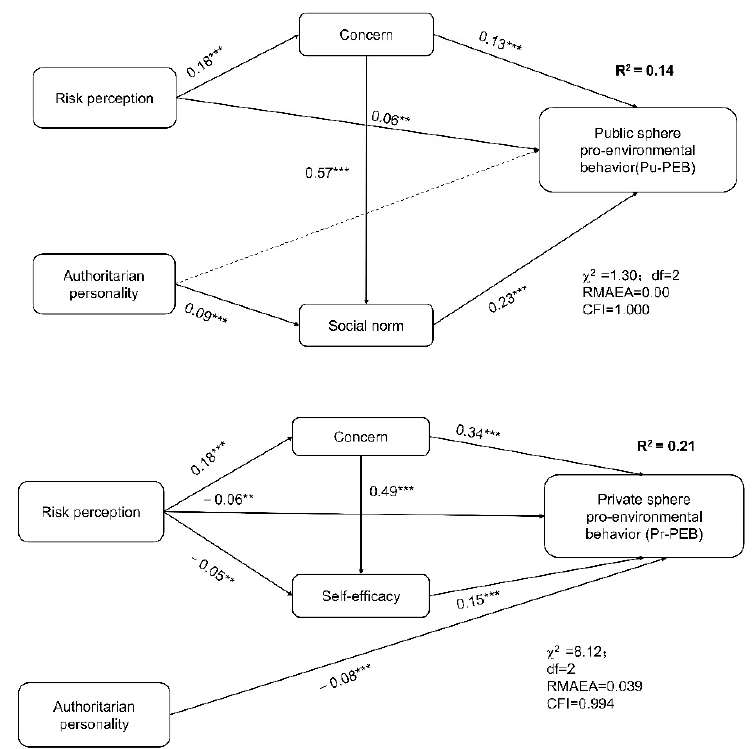
Figure 2. The relationship between risk perception, authoritarian personality, and pro-environmental behaviour both in private and public spheres. Note: The solid line represents significant influence, while the dashed line represents no significant influence. ** p < 0.01, *** p < 0.001.